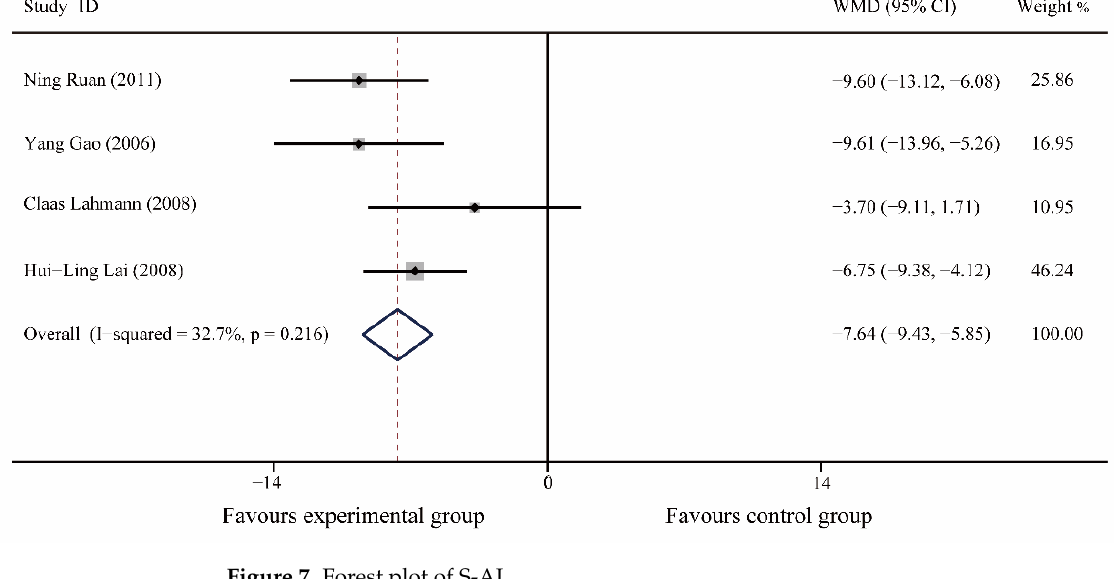
Figure 7. Forest plot of S-AI.